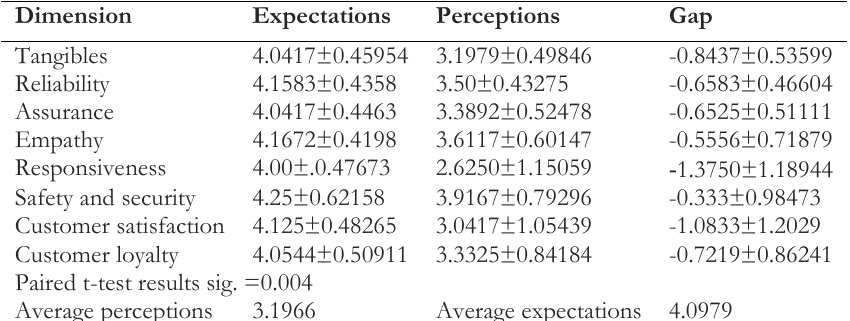
Table 10. Analysis gap quality analysis of reverse support services – hole of